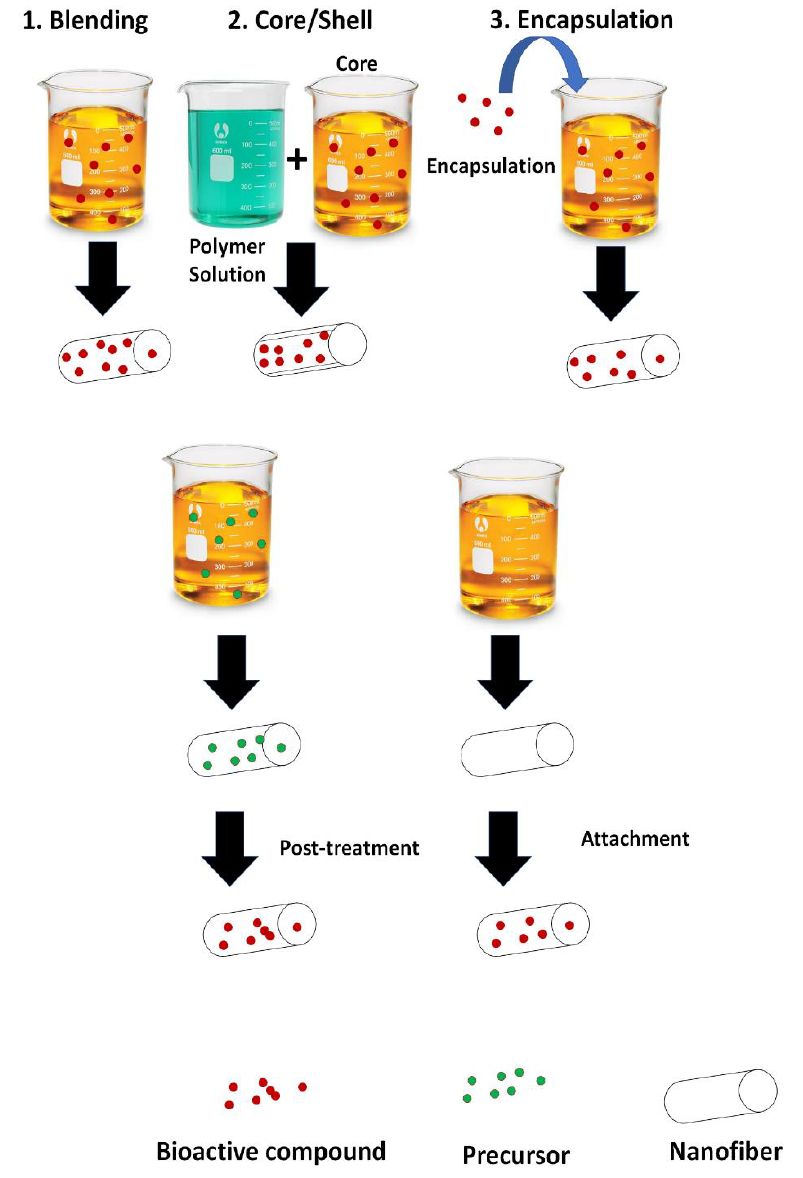
Figure 4. Methods for incorporation of bioactive compounds to nanofibers.